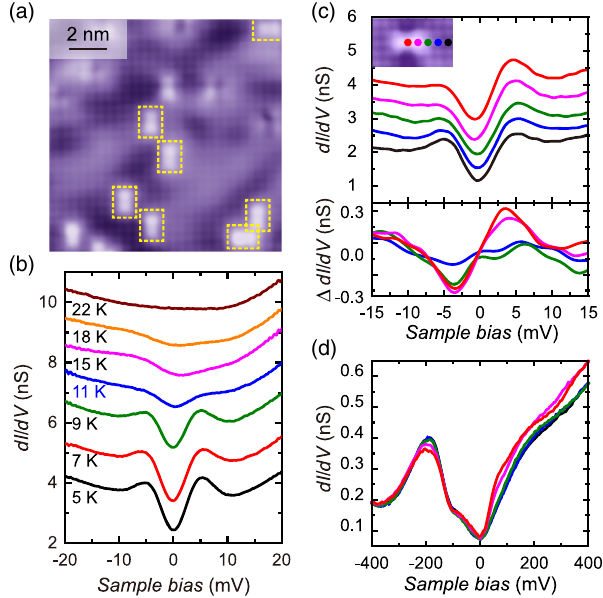
FIG. 2. (a) STM topography on the x ¼ 0 . 02 SC sample acquired with bias voltage V ¼ 10 mV and tunneling current I ¼ 300 pA. (b) Variable temperature dI=dV spectra (vertically offset for clarity) collected from a defect-free area across T ¼ 11 K, set up with V ¼ − 22 mV and I ¼ 100 pA. (c) C Upper panel: dI=dV curves (vertically shifted) at T ¼ 5 K taken at various locations (labeled by corresponding colored dot in the inset) in the vicinity of an isolated Cu dopant. The set-up conditions are V ¼ − 50 mV and I ¼ 100 pA. Lower panel: Spectroscopic variation around the Cu dopant, obtained by subtracting the dI=dV curves in (c) with the one taken 4 lattice away (black). The colors are the same as in (c). (d) Large bias dI=dV spectra taken at the same spots as in (c) with V ¼ − 500 mV and I ¼ 100